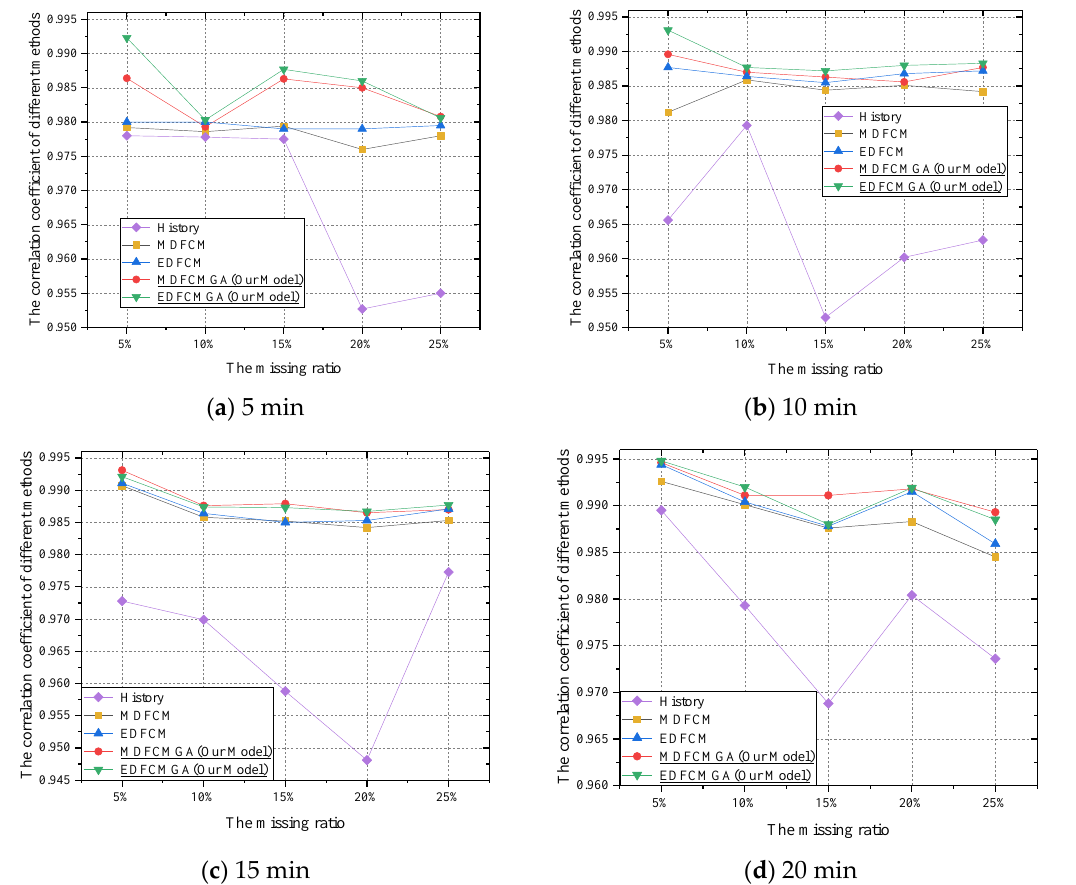
Figure 7. Correlation coefficient comparisons under the condition of different data aggregation intervals and different missing ratios.